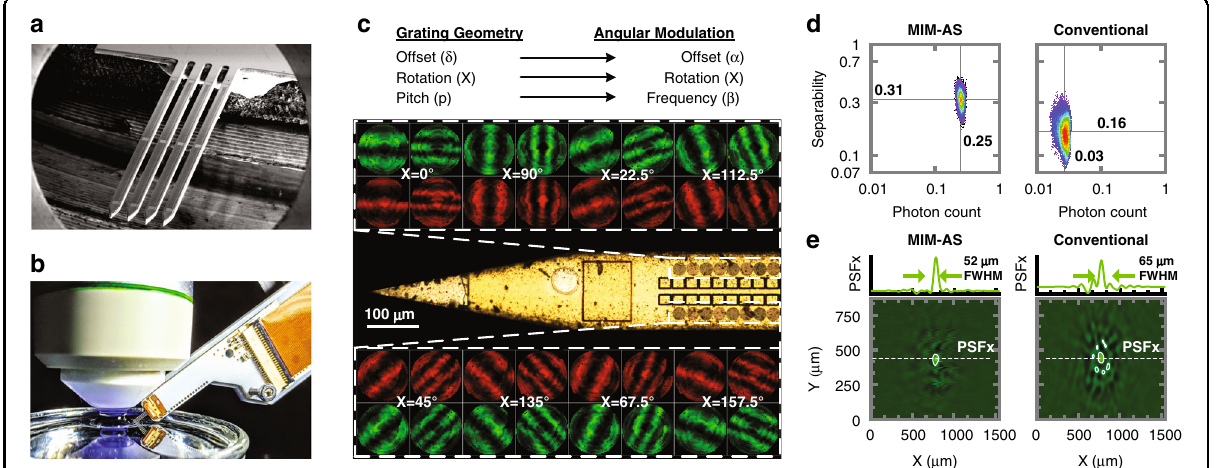
Fig. 3 MIMAS-CMOS implantable shanks. a The implantable imager consists of four shanks, each employing 2 × 128 SPAD pixels. b The chip is packaged and mounted on a micromanipulator for implantation. c Photomicrograph showing the 16 front end geometries distributed over the imager. Rotations ( χ ) are swept along the x -direction, grating pitch ( p ) and offsets ( δ ) placed adjacent. d The linear separability and relative photon count (compared with a SPAD with no mask) for all voxels in a 1000 × 1000 × 150 µm subset of the fi eld of view. The MIMAS (current work) is compared with a conventional metal-based angle-sensitive design where each pixel carries separate red and green fi lters for each pixel alternatively. e PSF in the XY plane at a height of 150 µm above the pixel ensemble with detail along y = 400 µm. A conventional angle-sensitive array without dual-bandpass fi lter shows distorted PSF, as its effective pixel density is